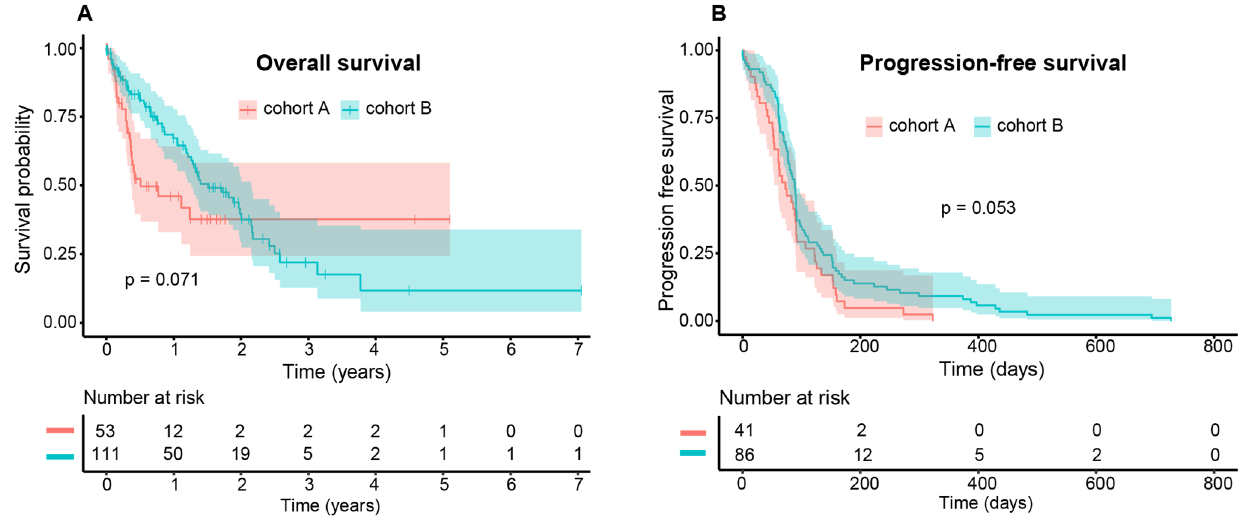
Figure 1. Kaplan–Meier estimates of the patient population for ( A ) OS and ( B ) PFS to ICB comparing cohort A (red) vs. B (turquoise). Although there was no significant difference in OS and PFS ( p = 0.071 and p = 0.053, resp.), the median survival differed considerably (cohort A 6.1 months (95%-CI: 4.4-NA) vs. cohort B 18.2 months (95%-CI: 15.1–25.9)). In contrast, the median PFS only differed slightly (cohort A 2.4 months (95%-CI: 2.0–3.0) vs. cohort B 2.9 months (95%-CI 2.5–3.0)).